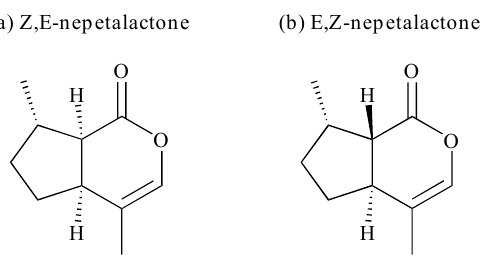
Figure 1. Structures of the two main nepetalactone isomers, Z,E -nepetalactone and E,Z -nepetalac- tone.